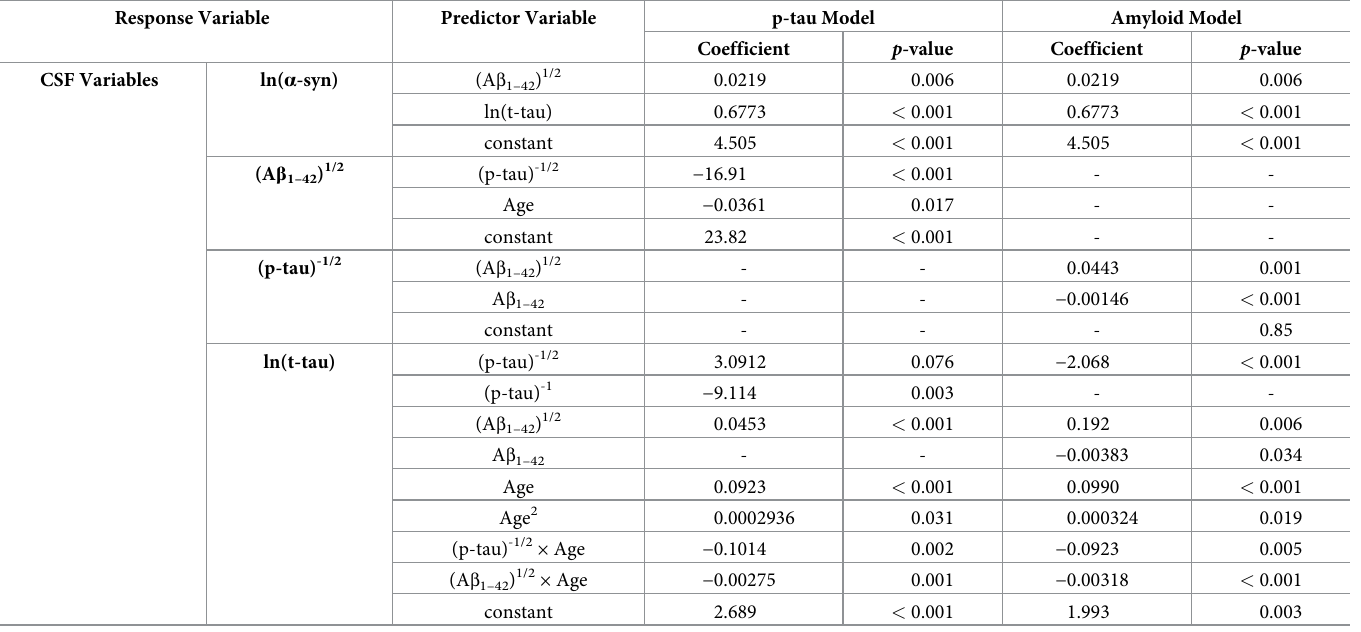
Table 2. Direct effects for the GSEM Networks in Fig 1B (p-tau Model) and Fig 2 (Amyloid Model). Response